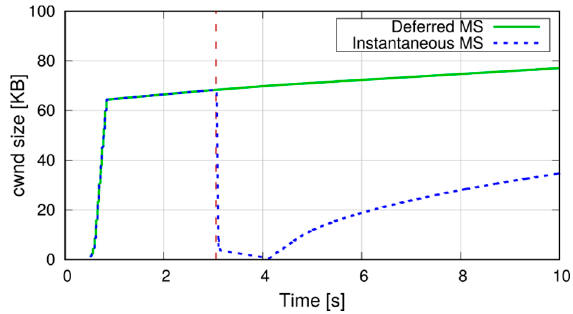
Figure 23. Congestion window of the TCP connection at a MS.